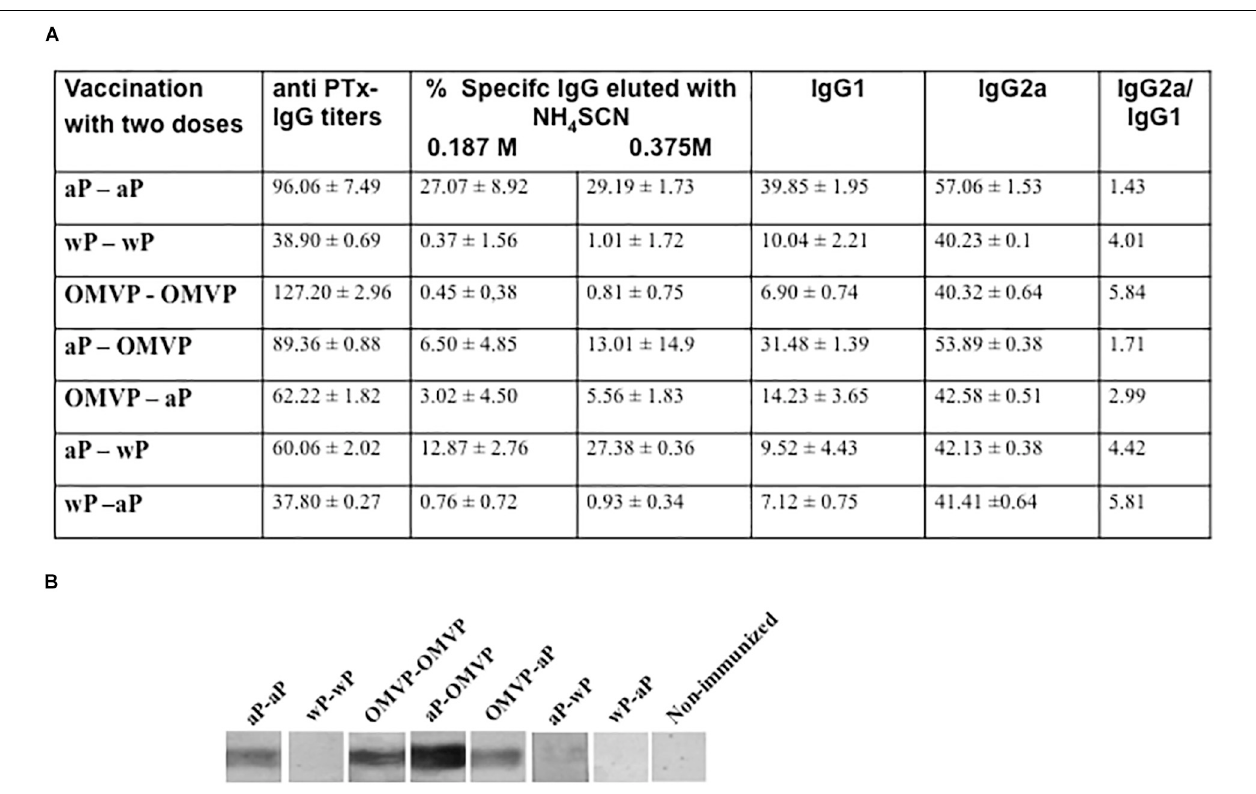
FIGURE 4 | Anti-Ptx antibodies induced by 2-dose vaccination schedules. (A) Anti-PTx IgG titers along with the IgG isotypes were measured 14 days after the second vaccination dose. The titers are expressed as the geometric mean of the data from each group. The cut-off levels for IgG, IgG1, and IgG2a assays were 12.5 ± 3.6, 1.9 ± 0.9, and 5.8 ± 2.7, respectively. No values were detected in the non-immunized control animals. The values detected were significantly different from those of the non-immunized mice ( p < 0.05). The avidity of IgG antibodies was also measured by ammonium thiocyanate (NH 4 SCH) elution 14 days after the second dose and is expressed as the percentage of PTx-specific antibodies eluted. (B) Immunoblotting of purified PTx separated by 12.5% (w/v) SDS-PAGE and probed with polyclonal sera obtained from immunized mice. The sera are designated according to the vaccination schedule used to raise the immune response in the donor